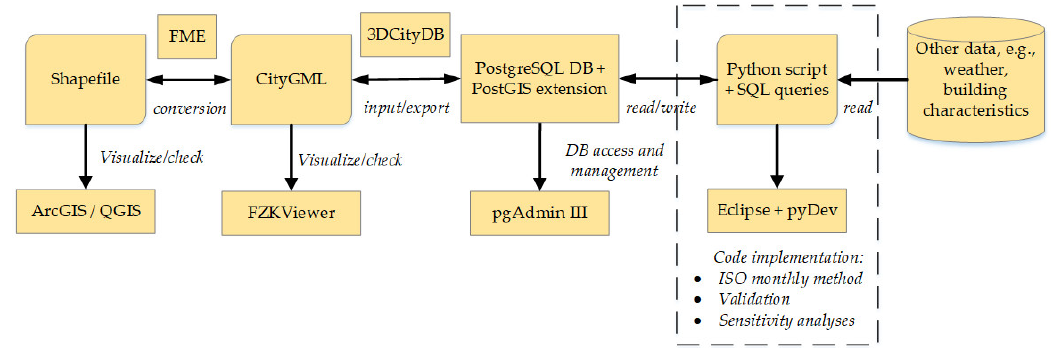
Figure 2. Overview of different software, tools and datasets required to implement CityBEM model (modified after Reference [30]).